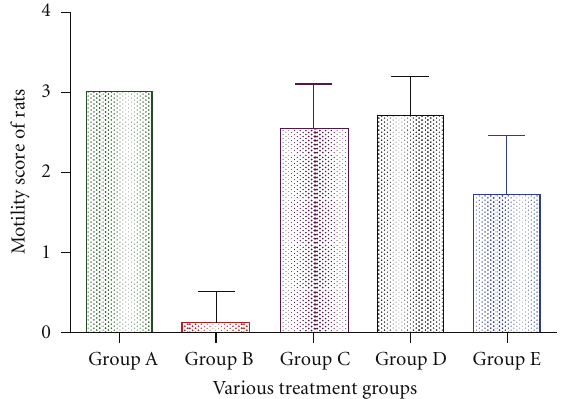
Figure 3: E ff ect of various drugs on impairment in motility associated with carrageenan-induced inflammation. Edema was induced by injecting 0.1 mL of 1% solution of carrageenan into subplantar surface of right-hind paw. The drugs were administered subcutaneously 30 minutes before injecting inflammagen. Motility score was observed at the time of peak inflammation (4 hours for carrageenan). Data are expressed as mean ± standard error of seven rats per group. Group A: carrageenan control; Group B: control; Group C: L. casei fed; Group D: L. acidophilus ; Group E: positive